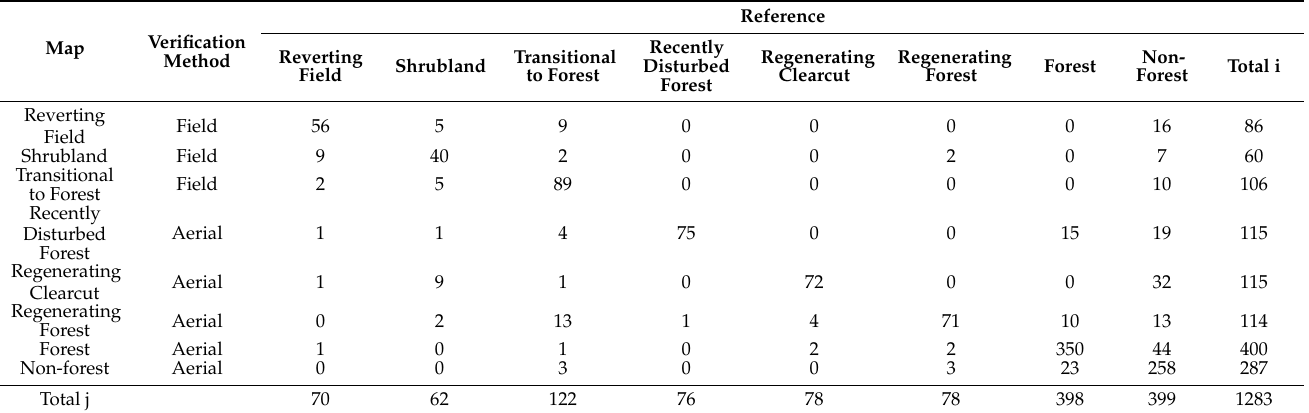
Table 3. Error matrix populated by sample counts. Verification methods included field visits (Field) and aerial photo interpretation